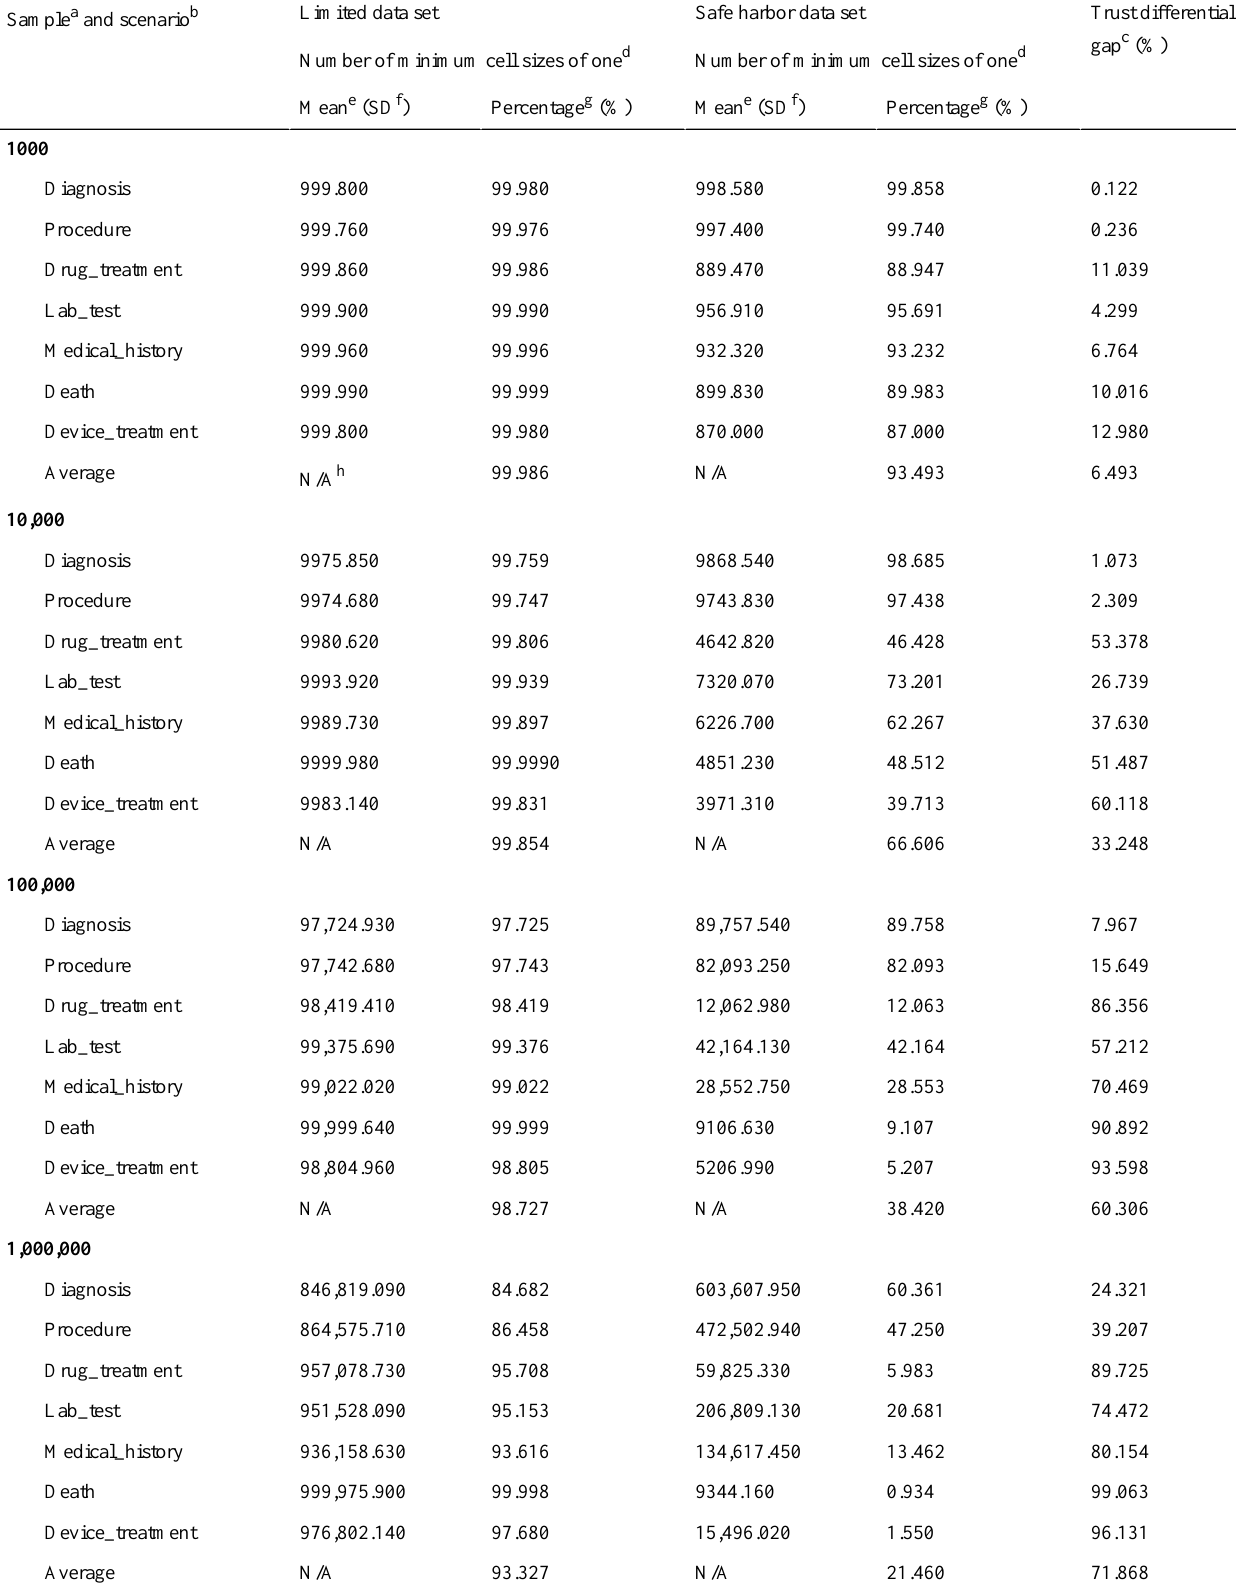
Table 6. Comparison of records with a minimum cell size of one between the limited and safe harbor data sets from seven scenarios.